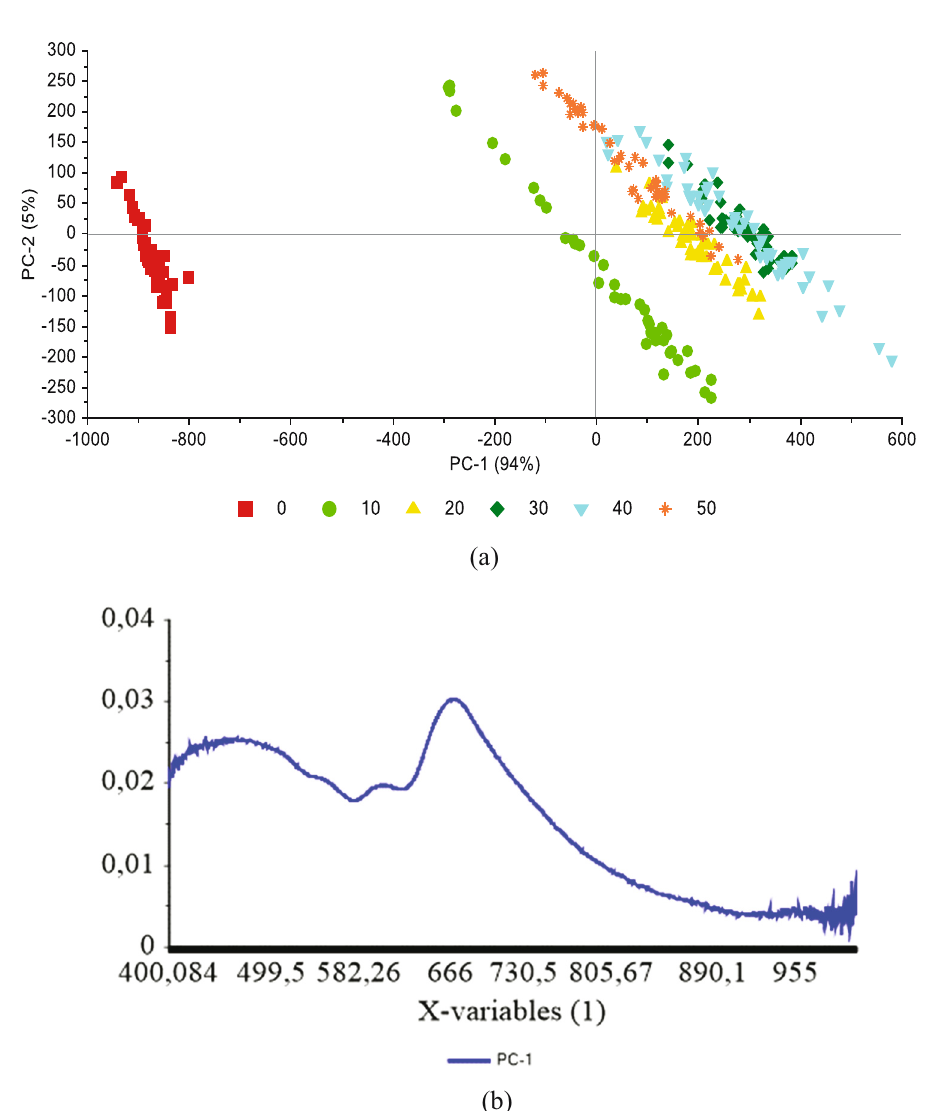
Figure 4: PCA of pure ( 0% adulterant ) and maltodextrin - adulterated butter fl y - pea extract powder at 10, 20, 30, 40, and 50% concentrations: ( a ) score plot; ( b ) loading plot using the original